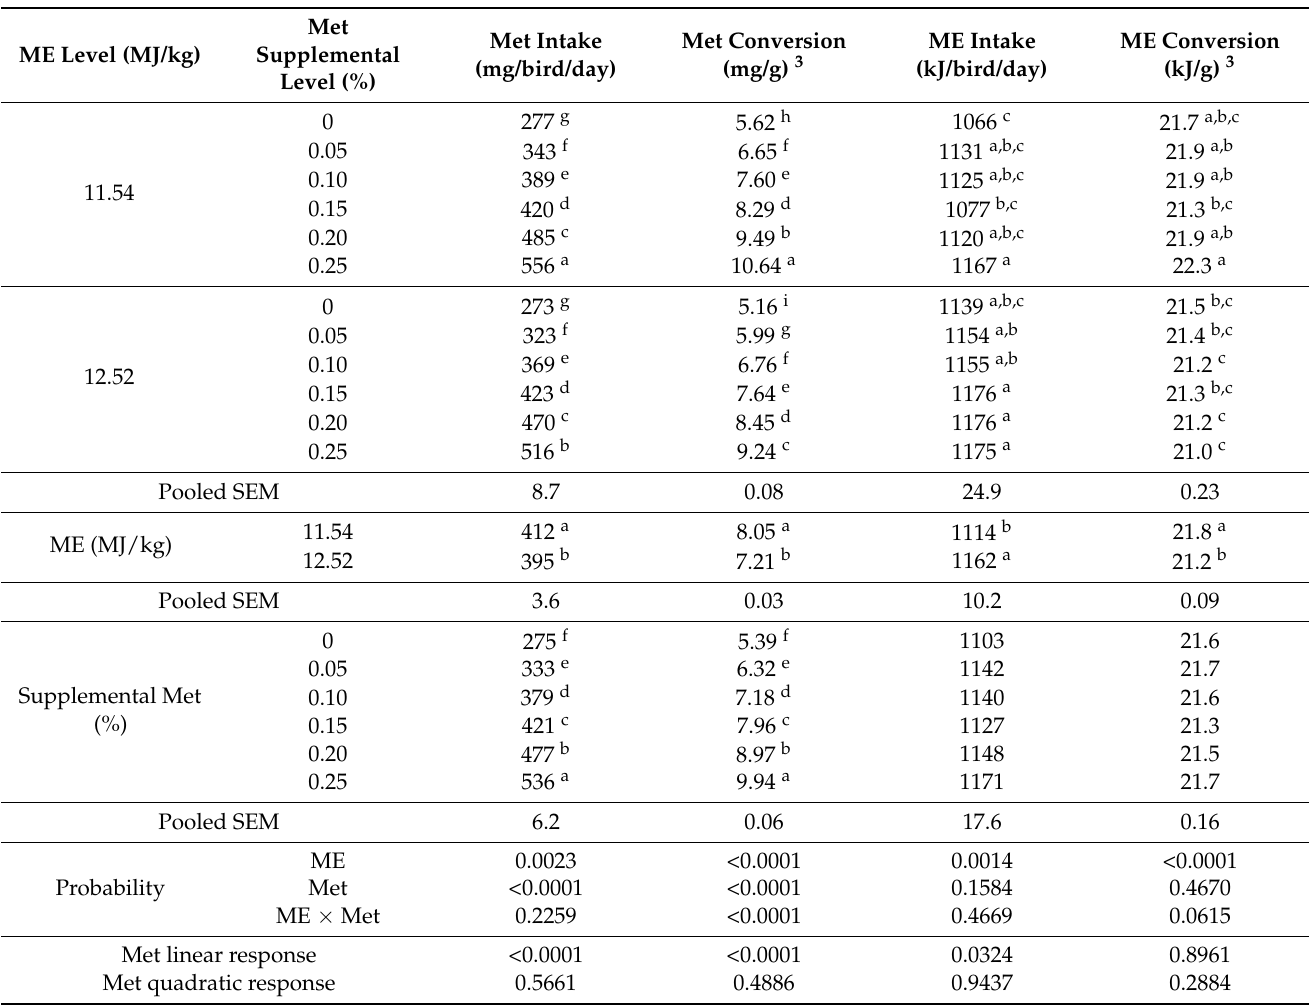
Table 3. Effects of dietary metabolizable energy and methionine on metabolizable energy and methionine intake and conversion of starter Pekin ducks from 1 to 21 days of age 1,2